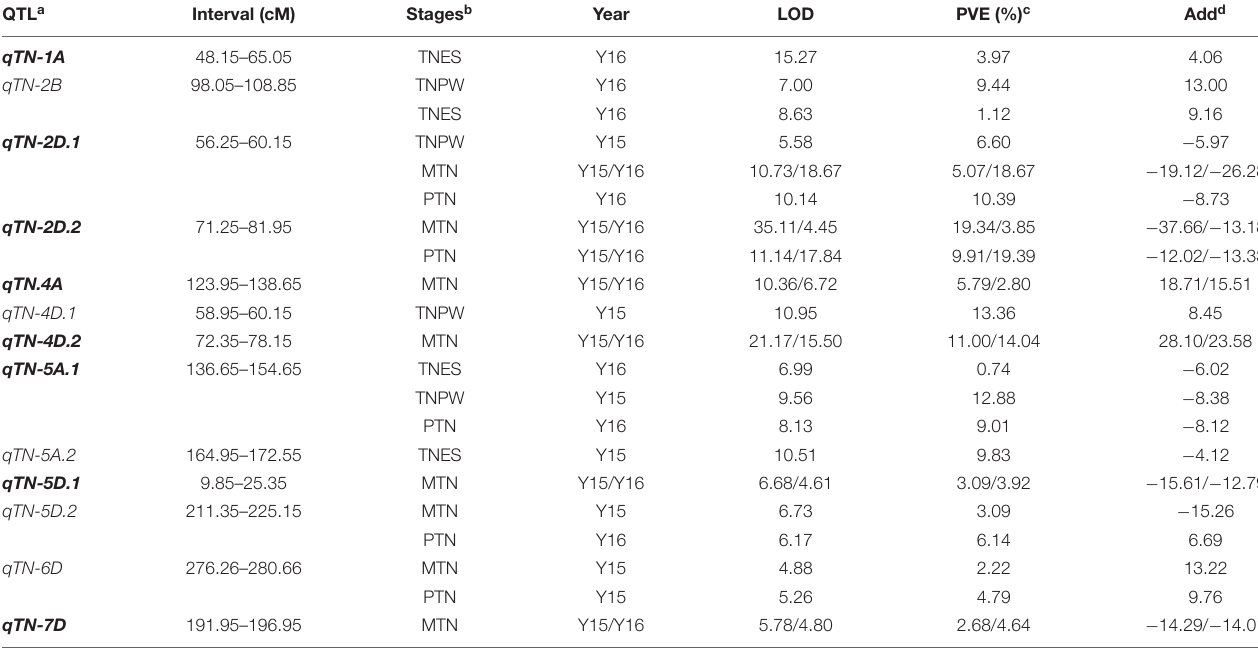
TABLE 3 | Putative additive QTL for TN at different growth stages by ICIM